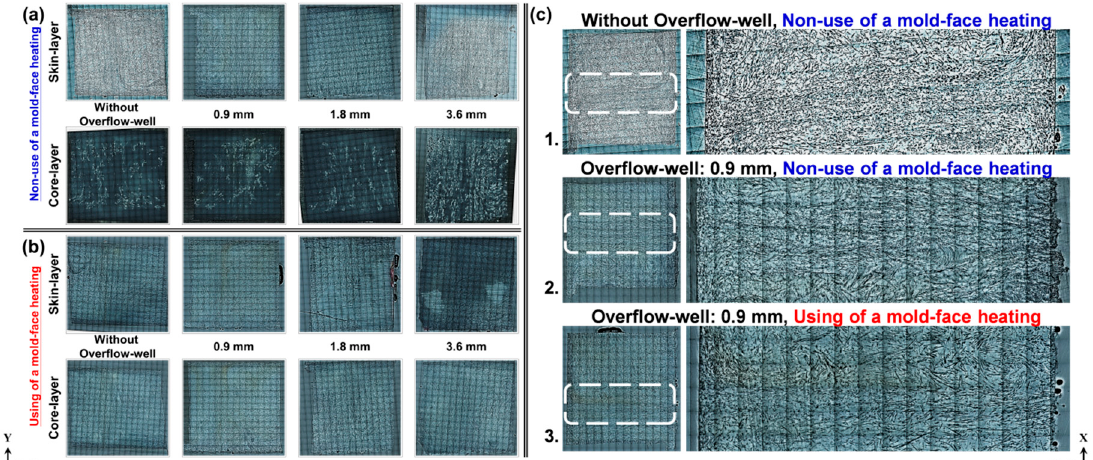
Figure 7. Optical-microscopy (OM) images of samples with di ff erent overflow-well depth and mold-face temperatures: ( a ) level of incompatibility between fibers and melts as a function of overflow-well depth and fiber orientation; ( b ) level of incompatibility between fibers and melts as a function of use-mold-face heating and fiber orientation; and skin layers of samples: ( c1 ) without overflow-well and mold-face heating; ( c2 ) using an overflow-well with a depth of 0.9 mm without mold-face heating;